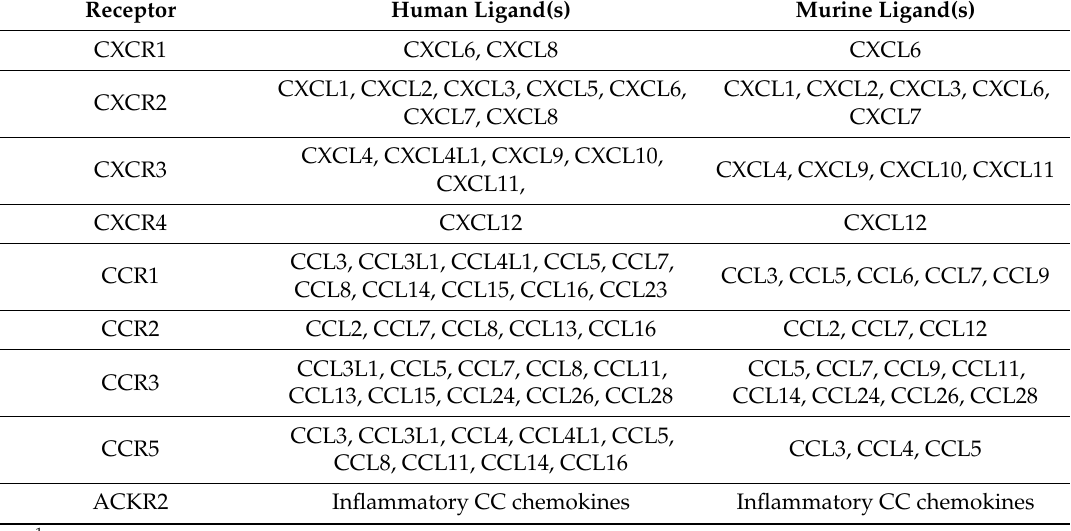
Table 1. Chemokine receptors expressed on neutrophils and their human and murine ligands 1